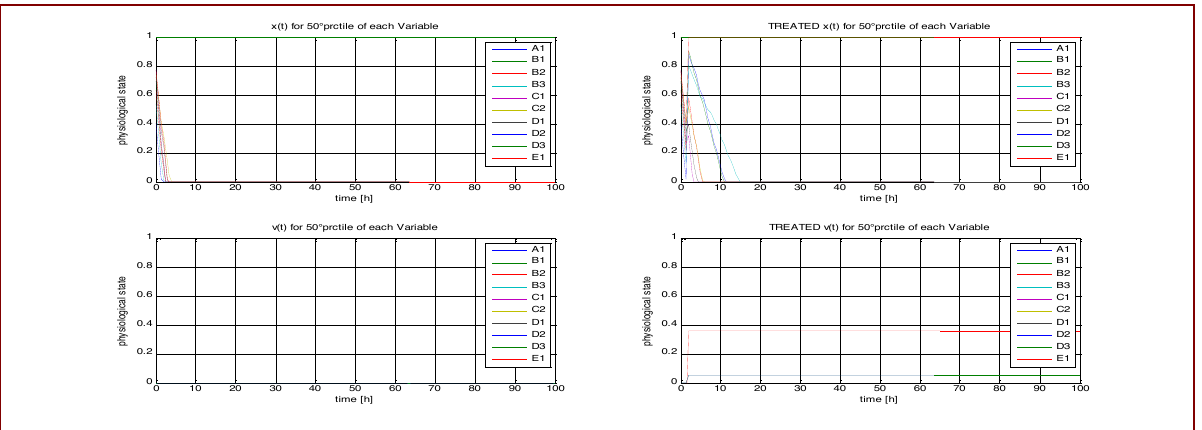
Fig. 8. On the left-hand side, it is shown the evolution of median UNTREATED patient (x(t) and v(t)) for each variable in the set (ABCDE); on the right-hand side, it is shown the evolution of median TREATED (decontamination) patient (x(t) and v(t)) for each variable in the set